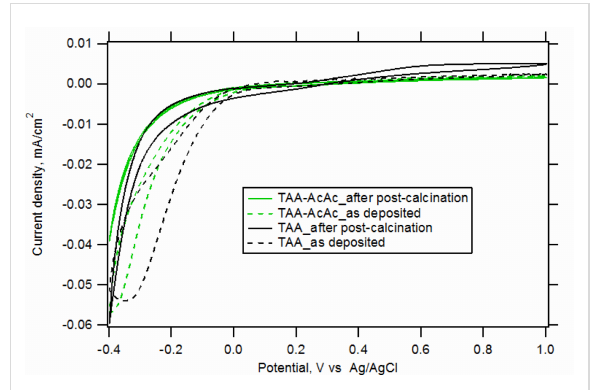
Figure 8: Cyclic voltammograms of FTO(B) covered by sprayed TiO 2 films made of 70 SCs of 0.2 M TAA and of 0.2 M TAA-AcAc. Scan rate 50 mV/s. Electrolyte solution was 0.5 mM Fe(CN) 63 − /4 − in aqueous 0.5 M KCl, pH